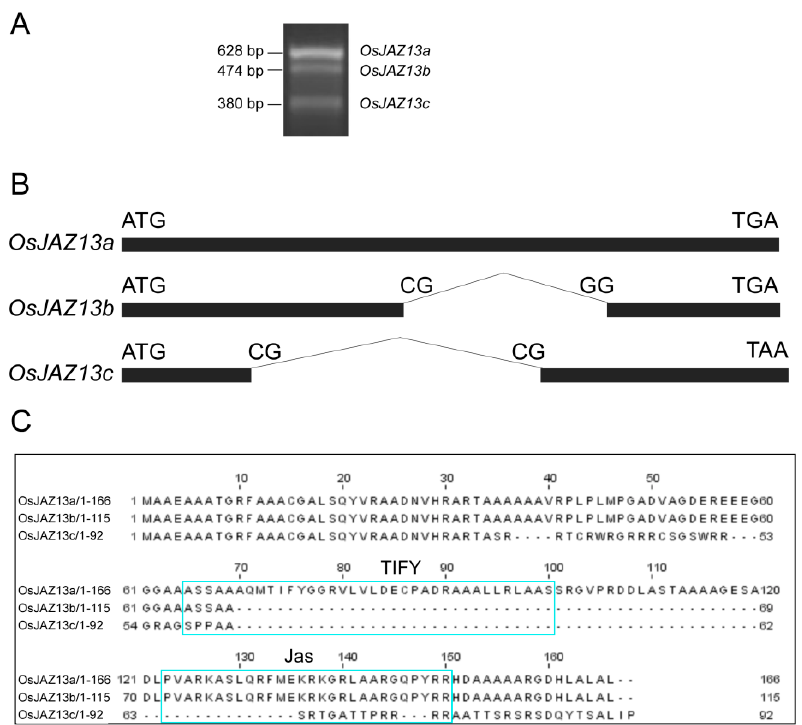
Figure 1. Identification of three alternative splicing variants of OsJAZ13 . ( A ) RT-PCR analysis of OsJAZ13 transcripts using RNAs isolated from MH86 at the grain filling stage. This experiment was performed for at least three independent biological repeats. ( B ) Schematic diagram of alternatively spliced transcripts OsJAZ13a , OsJAZ13b , and OsJAZ13c , respectively. Blank box represented exons. ( C ) Alternative splicing differentially affects domain distribution in the three OsJAZ13 splice variants.